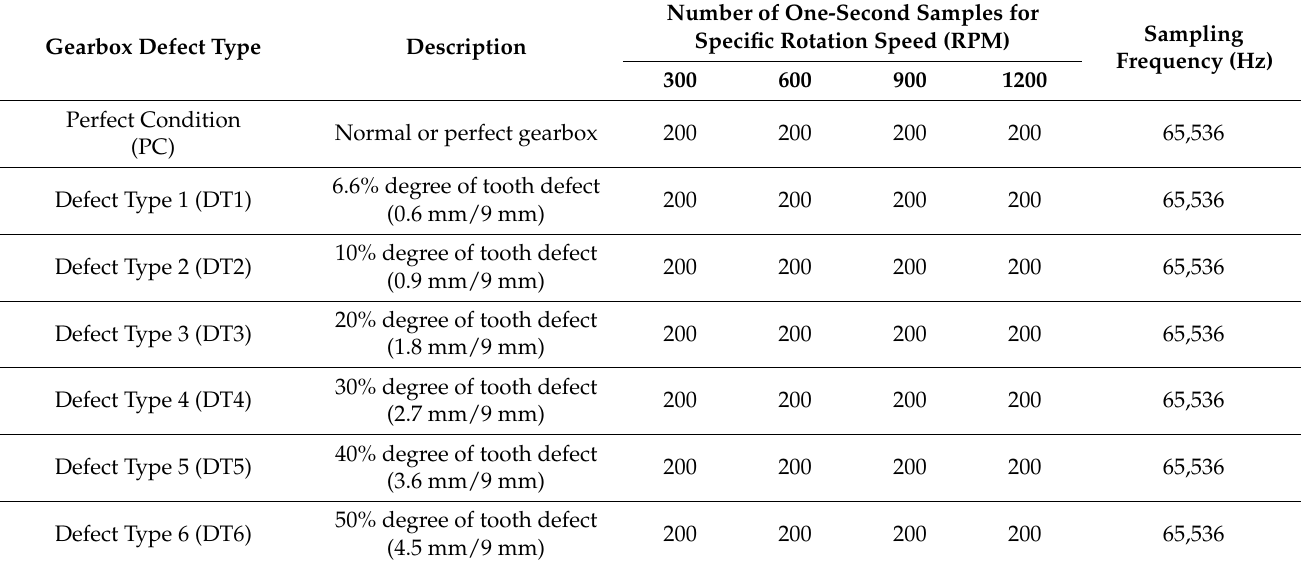
Table 2. The configuration of the MDTF gearbox